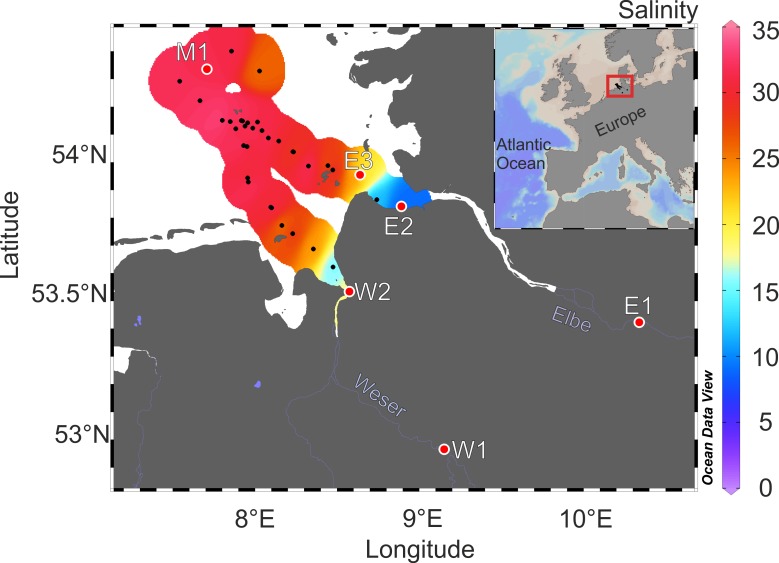
Map of sampling area.Sampling locations are marked as red dots, colors represent the surface salinity. Black dots represent stations, at which temperature and salinity were measured [39].